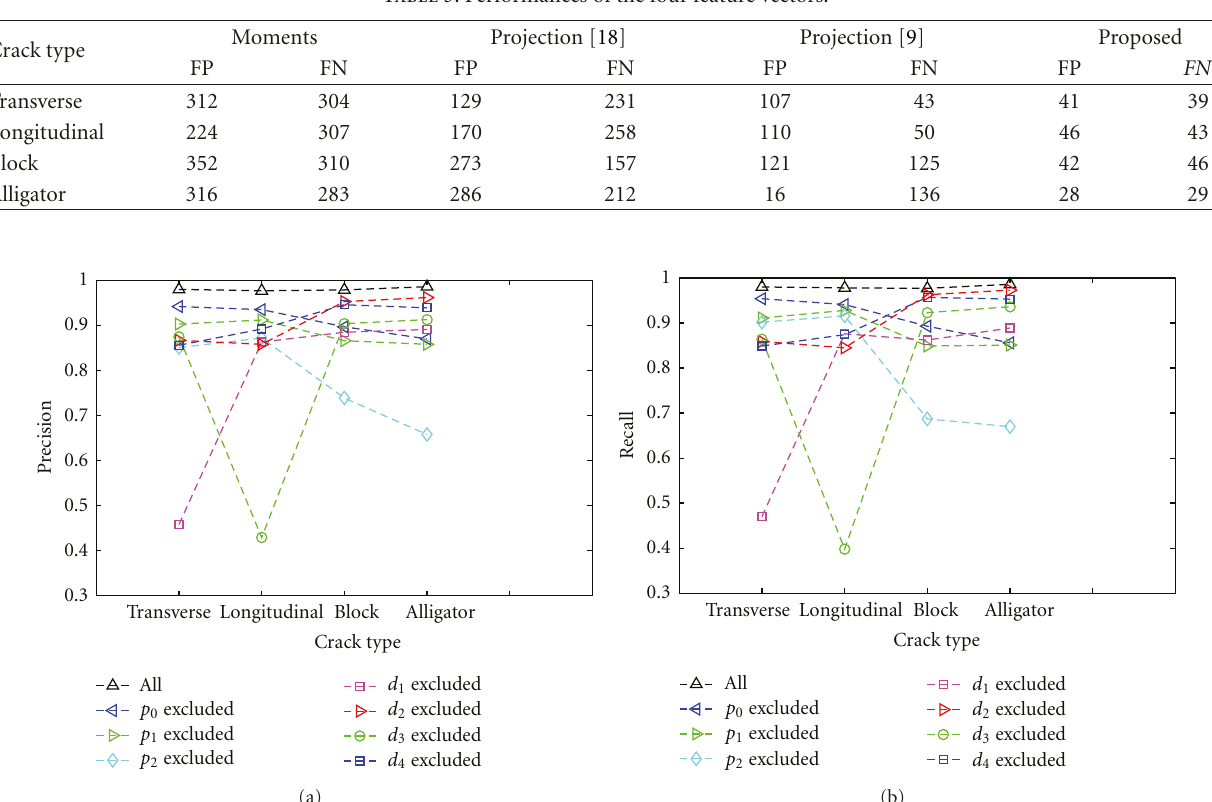
Table 3: Performances of the four feature vectors.